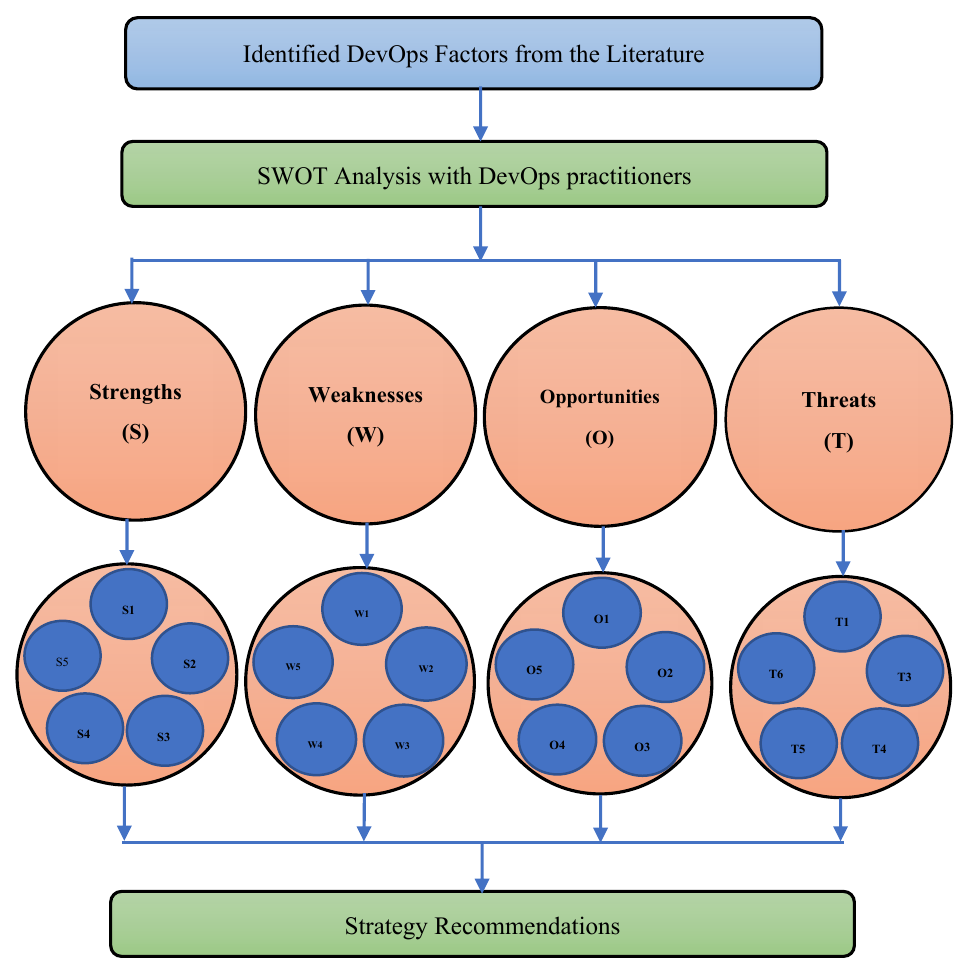
Figure 5. The SWOT structure .